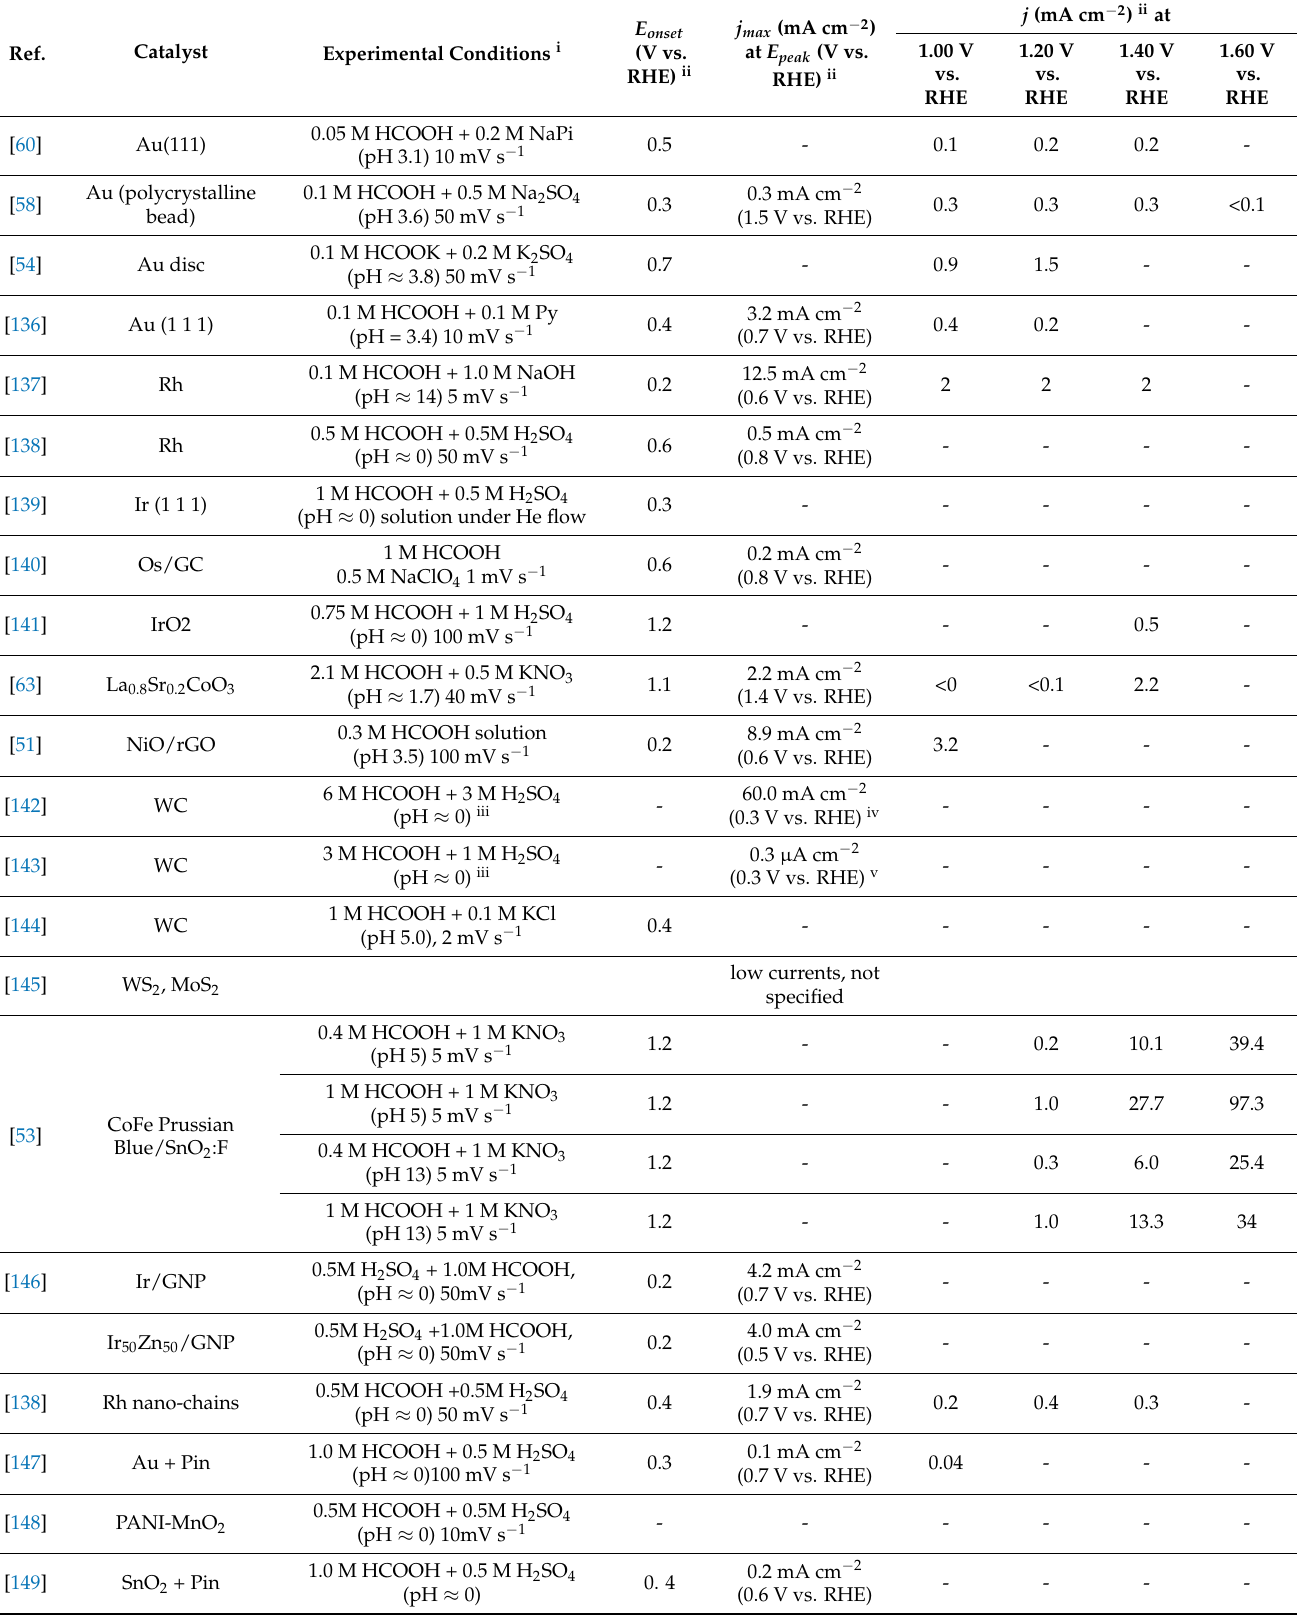
Table 4. Summary of Pt and Pd-free materials used in electrocatalytic formic acid/formate electrooxidation.